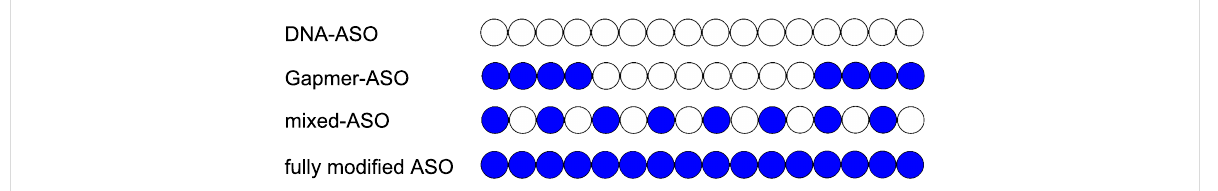
Figure 1: A schematic representation of 16-mer ASOs in different designs. White circles represent unmodified DNA monomers; blue circles represent nucleotide modifications. The gapmer-ASO shown is an example of a so-called 4-8-4 gapmer. The patterns of modified and unmodified nucleotides may vary and only examples are shown. Also, the phosphodiester linkages between the nucleotide monomers may be modified, and here phosphoro- thioate linkages are often